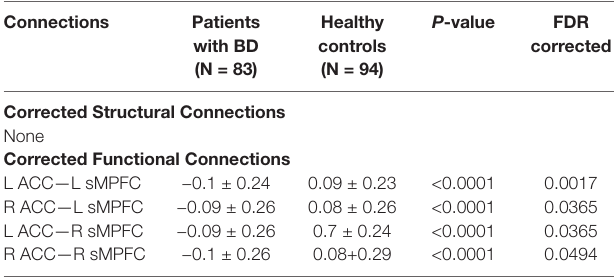
TABlE 2 | After controlling for age, gender, and educational years, functional connections showing significantly altered connection strength in patients with BD compared to